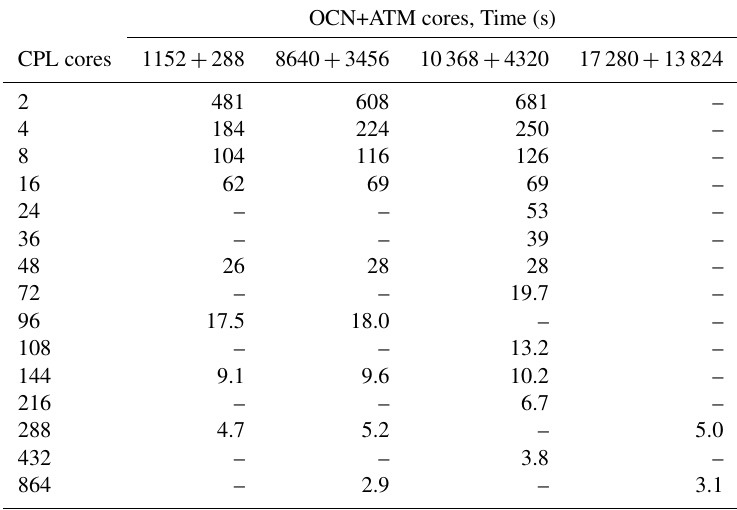
Table 1. The same data as in Fig. 4, with added BlueGene/Q data from Fig. 3.